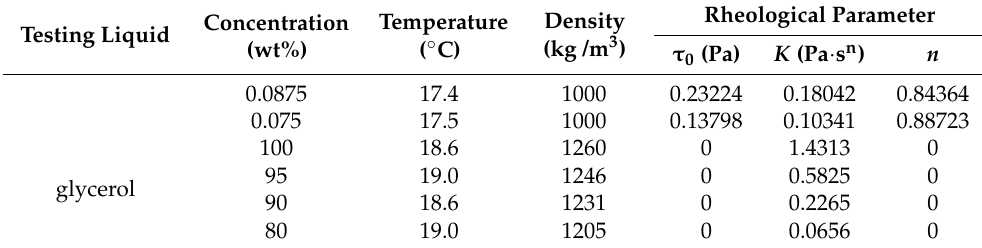
Table 2. Rheological test results of Carbopol aqueous solution and glycol aqueous solution for ex- periments.